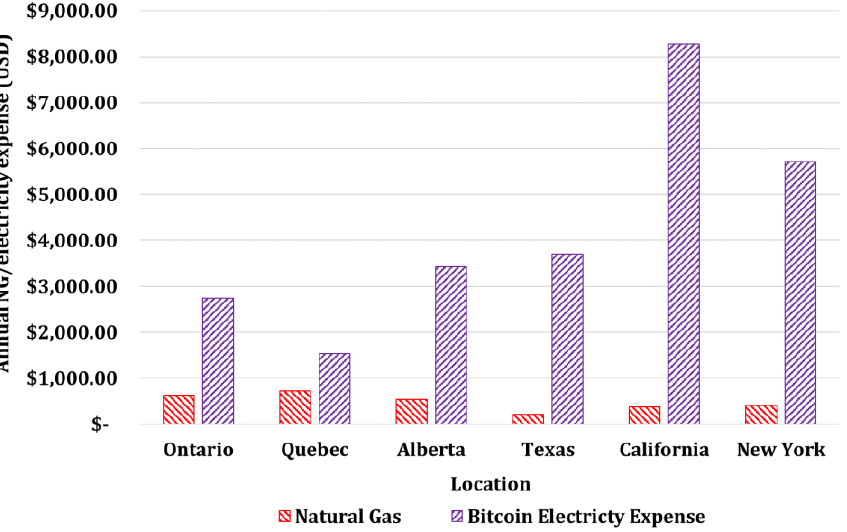
Figure 31. Annual heating expense of natural gas compared to electricity used to operate a Bitcoin mining system in six North American locations to heat Greenhouse 1.